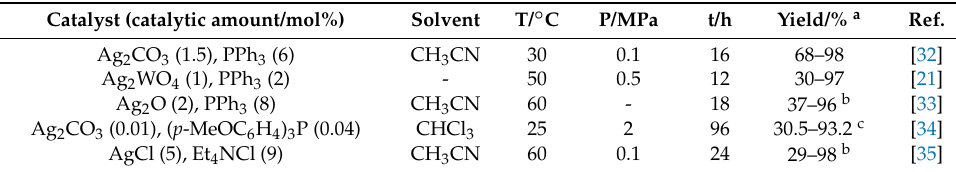
Table 1. Silver-containing catalytic systems.